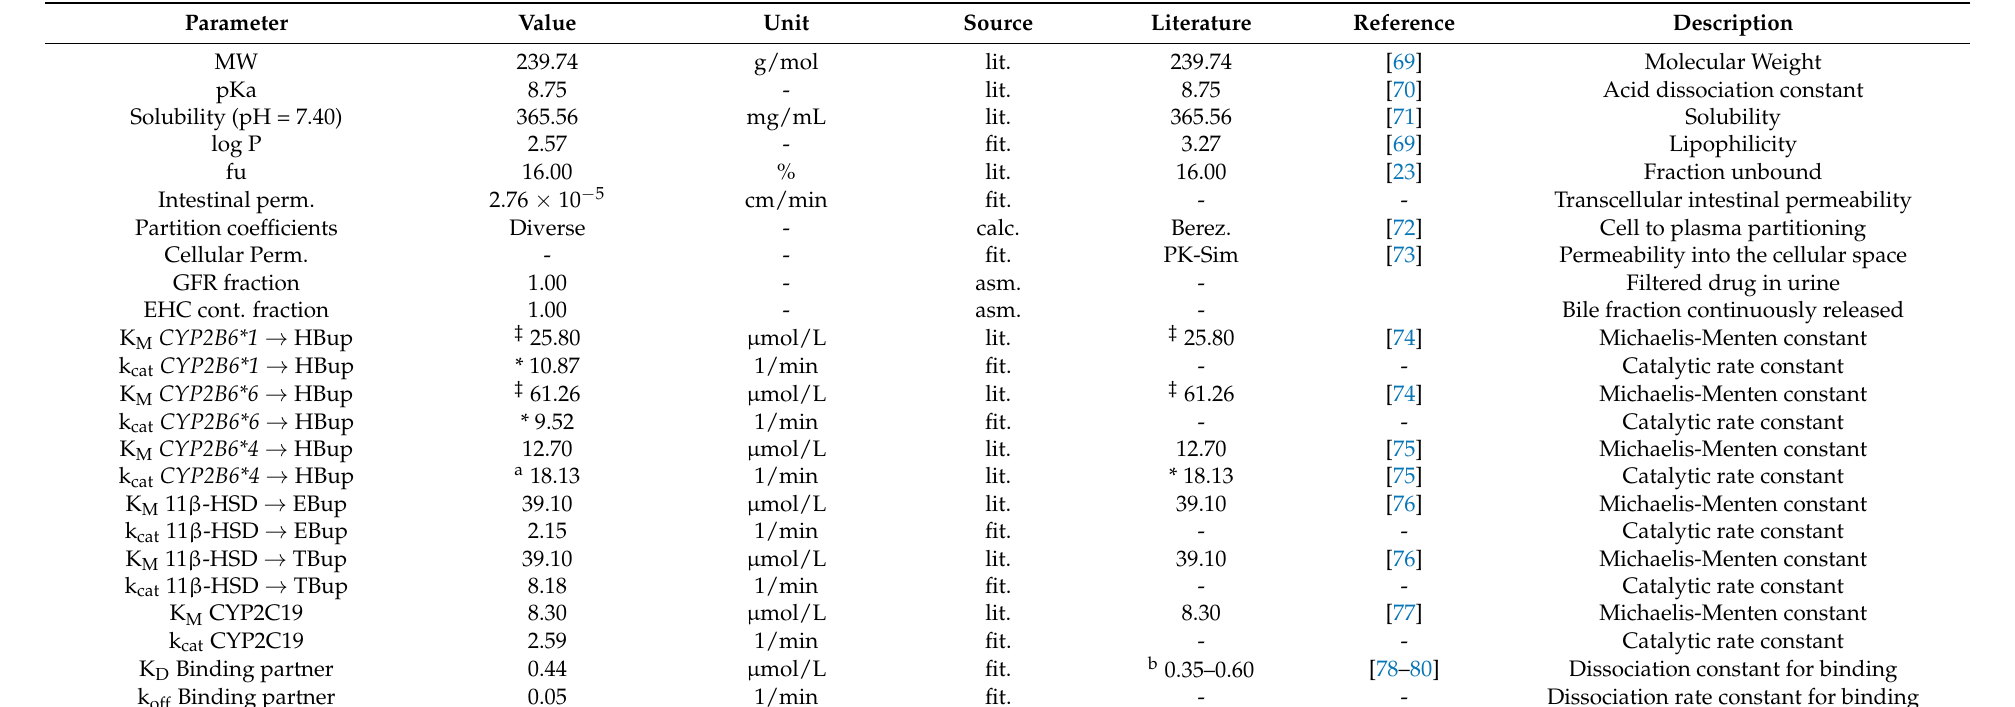
Table 1. Drug-dependent parameters of the bupropion PBPK